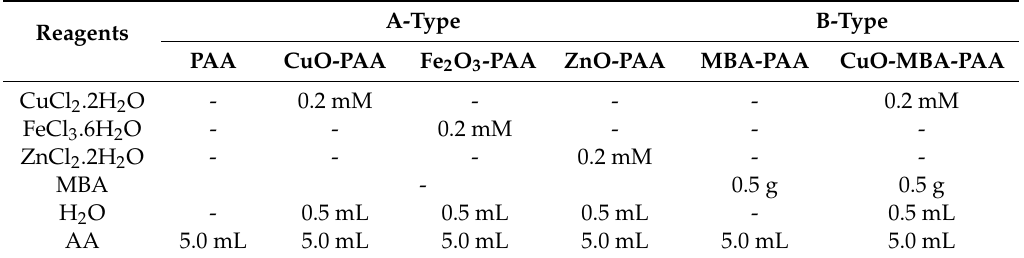
Table 1. Precursors and experimental conditions used for AC plasma deposition onto ITO surface.